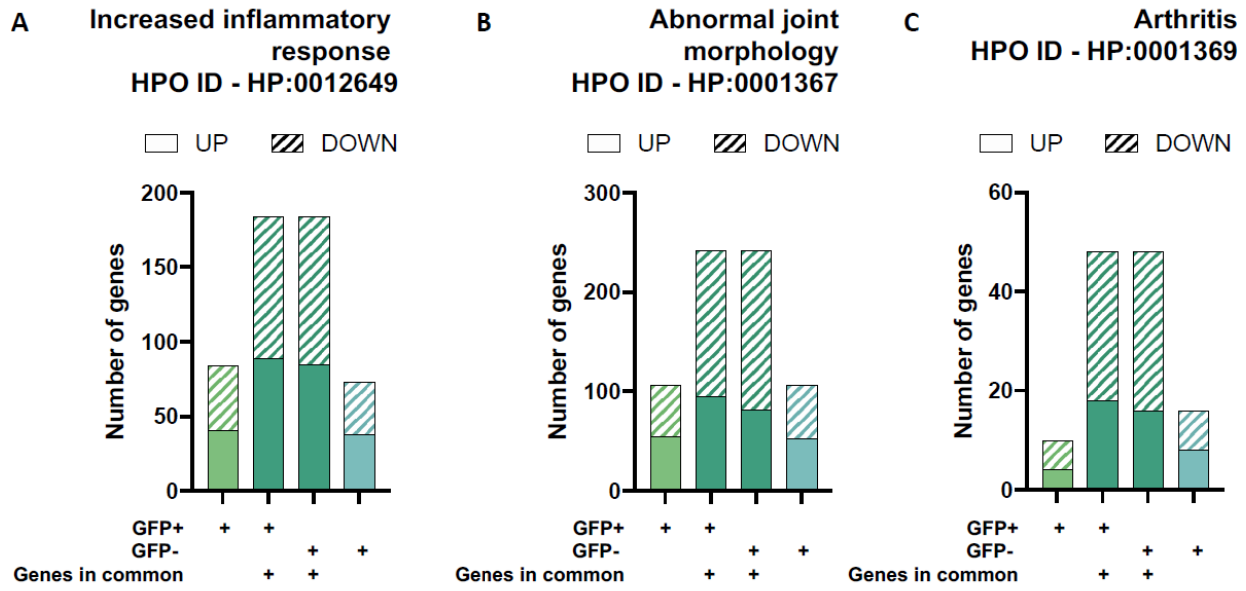
Figure 5. Differential gene expression for gene-sets related to joint pathology. The proportion of up-